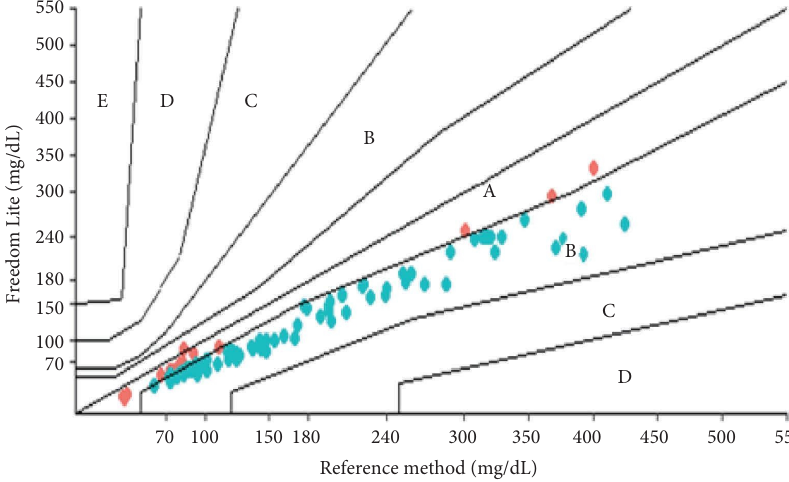
Figure 6: Error grid for the FreeStyle Freedom Lite ® glucometer.